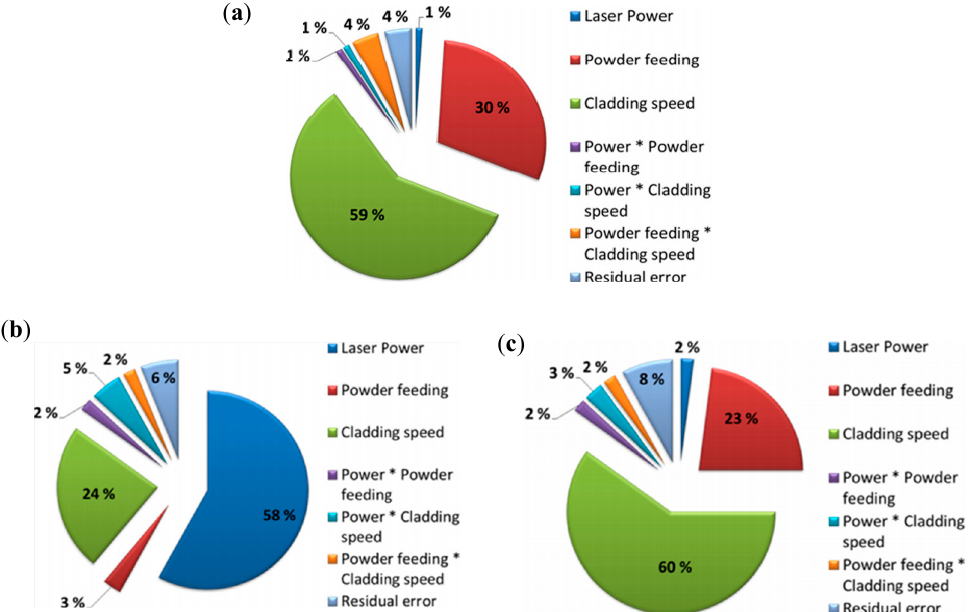
Figure 2. Influence of laser cladding process parameters on the geometric shape of the cladding coating. ( a ) The effect of cladding speed on the height of the cladding coating, ( b ) the effect of laser power on the change of the cladding coating width, and ( c ) the effect of cladding speed on the change of the wetting angle between the cladding coating and the substrate.